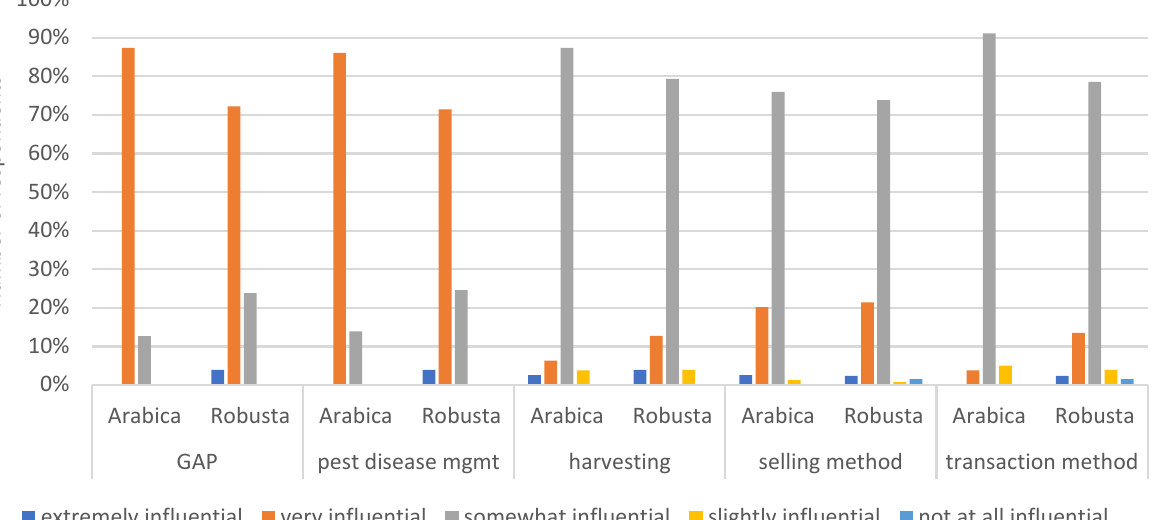
Figure 4. The proportion of coffee farmers who experienced affects in the farming process aspect as a result of COVID-19.